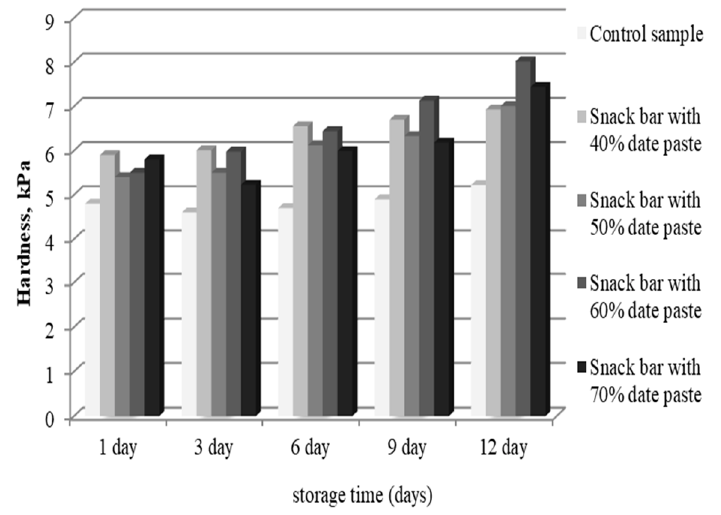
Figure 4. Changes in the hardness of five snack bar samples during 12-day storage.